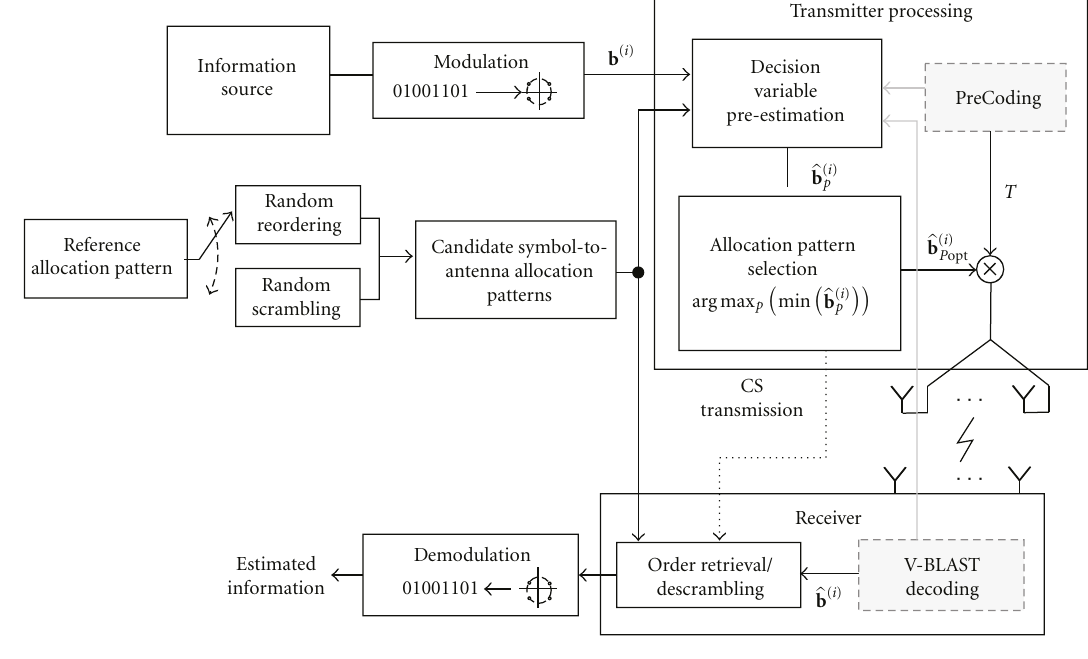
Figure 1: Block diagram of the proposed symbol allocation (SA) scheme.